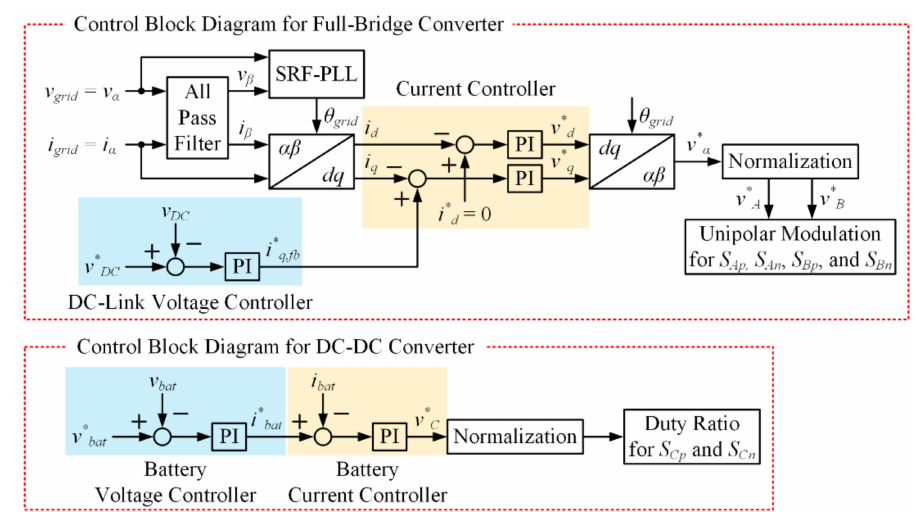
Figure 3. Control block diagrams of the integrated OBC operated in battery charging